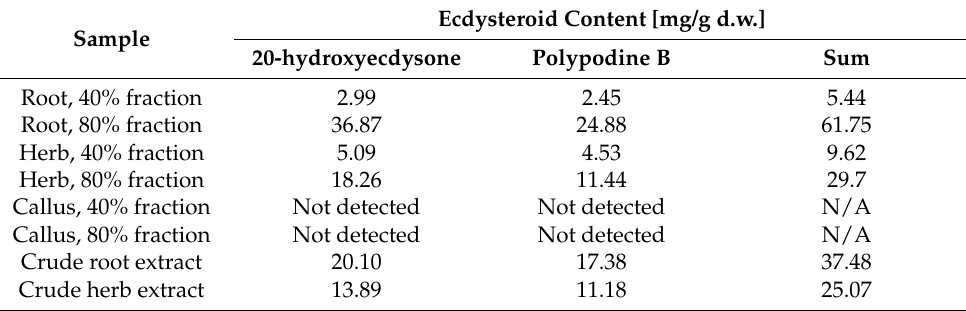
Table 9. The content of 20-hydroxyecdysone and polypodine B in fractions and crude extracts used for bioassays, expressed as the mg/g of dry weight of the sample. Ecdysteroid Content [mg/g Sample